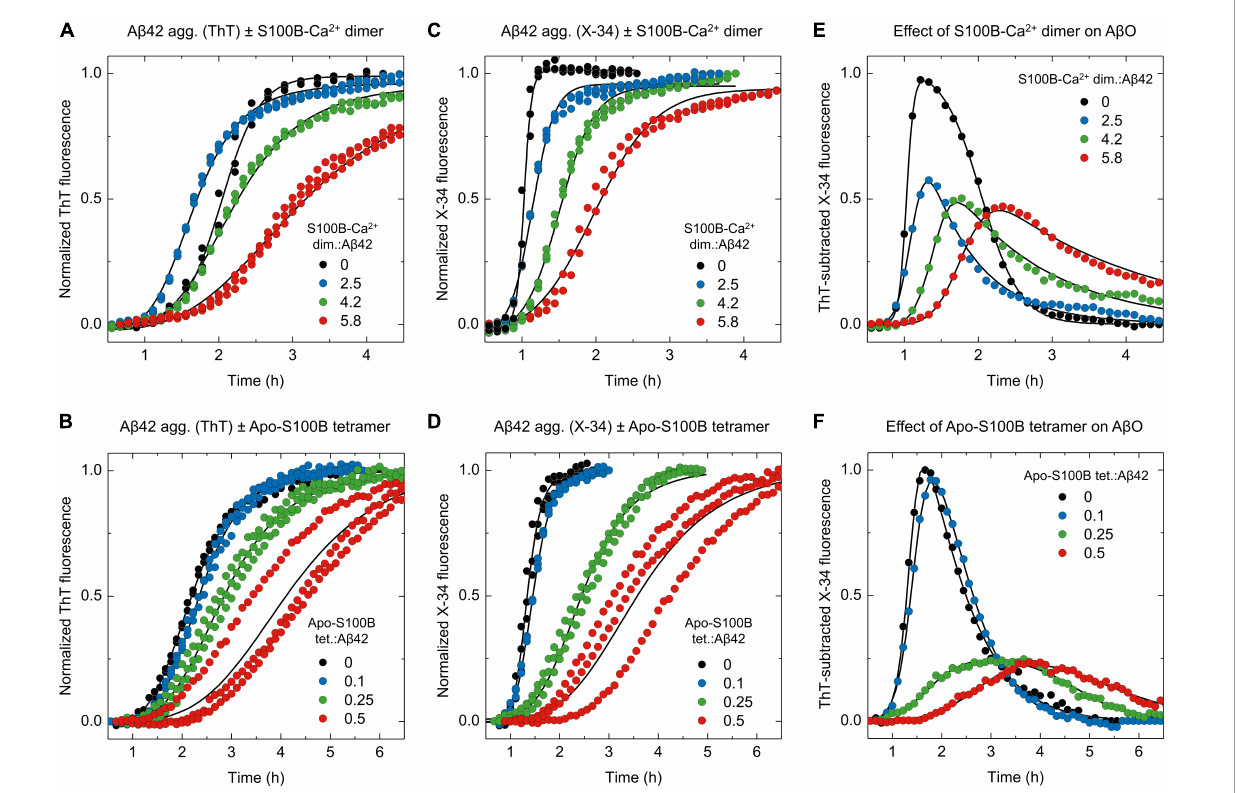
FIGURE4 ThT and X-34 differential fluorescence analysis support the S100B dimer and tetramer suppressor effect over A β 42 oligomeric species. Normalized kinetic traces of (A,B) ThT or (C,D) X-34 monitored aggregation of monomeric A β 42 [6 µ M in panels (A,C) or 2 µ M in panels (B,D) ] in the presence of increasing molar ratios (A,C) of S100B-Ca 2 + dimer:A β 42 (0–5.8) or (B,D) apo-S100B tetramer:A β 42 (0–0.5). ThT subtracted X-34 kinetic traces (average values, n = 3) of all (E) S100B-Ca 2 + dimer and (F) apo-S100B tetramer concentrations assayed. Non-normalized kinetic traces are depicted in Supplementary Figure 4